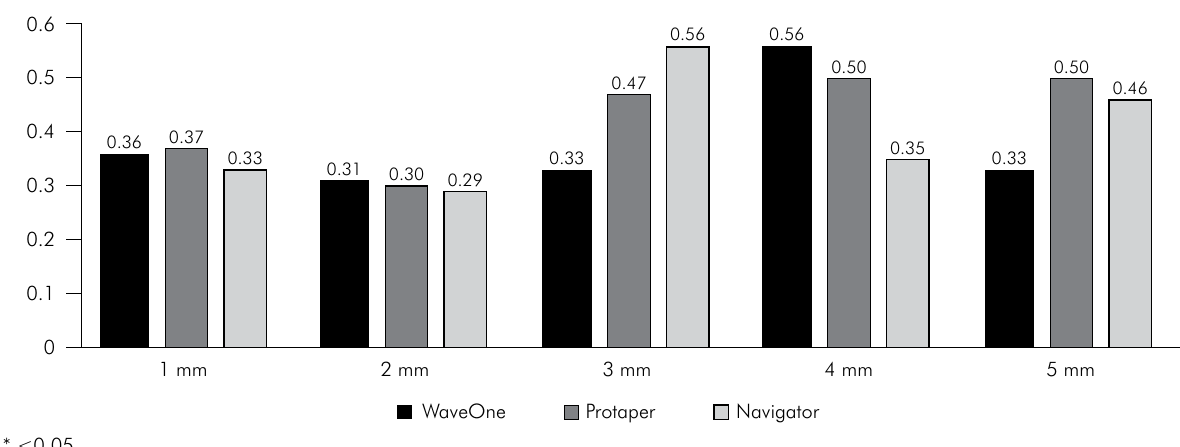
Figure 3. Centering ratio. A result of one indicates perfect centering ability; the closer the result is to zero , the worse the ability of the instrument to remain